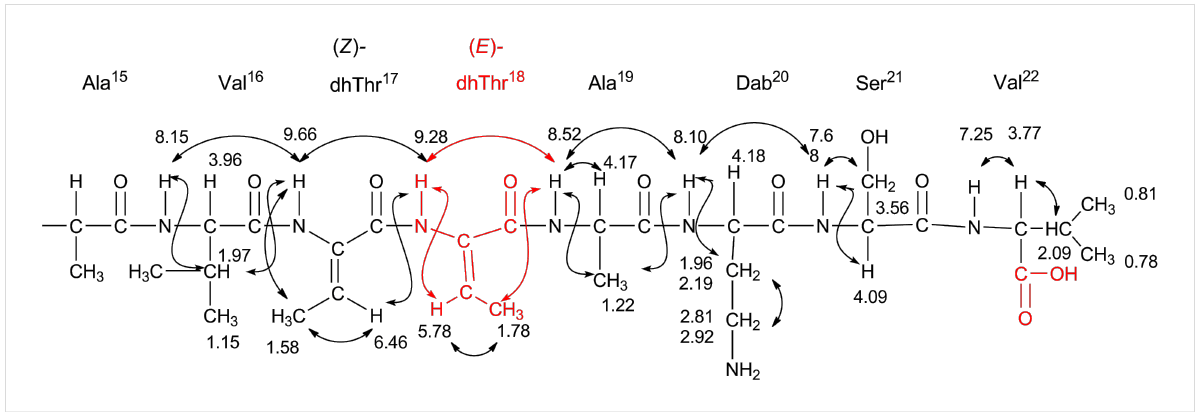
Figure 8: Partial structure of compound A as deduced from its NOE data; key NOEs are represented by double-headed arrows. The δ H (ppm) are given, and these signals were measured in DMSO- d 6 (600 MHz). The double bond of dhThr 18 was in the E -configuration.